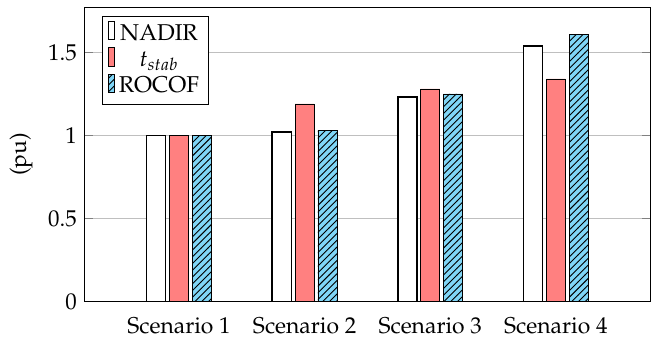
Figure 12. Frequency excursions for scenarios 1–4 without wind power plant control